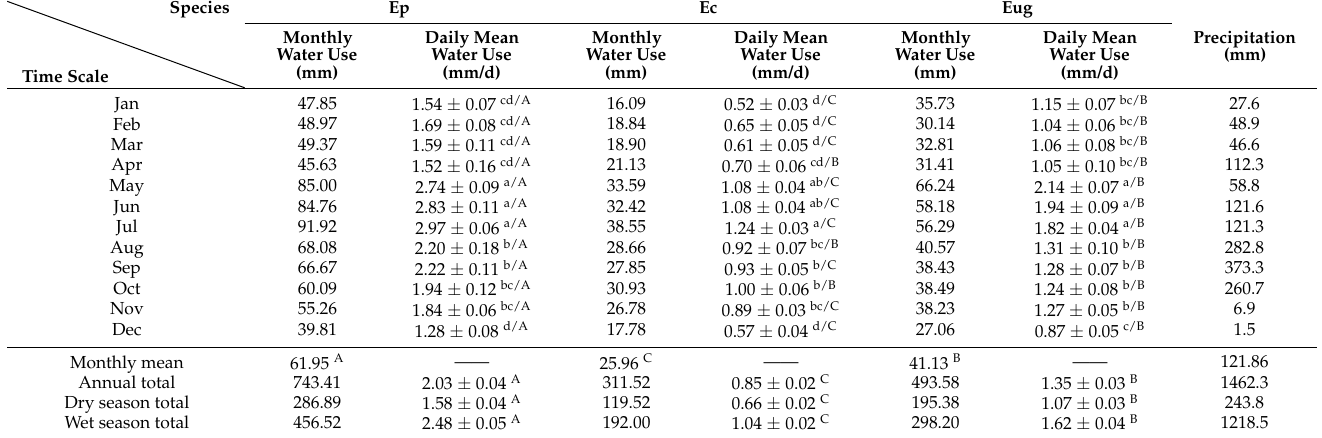
Table 2. Summary of stand-level canopy transpiration values for the three eucalyptus species plantations at different time